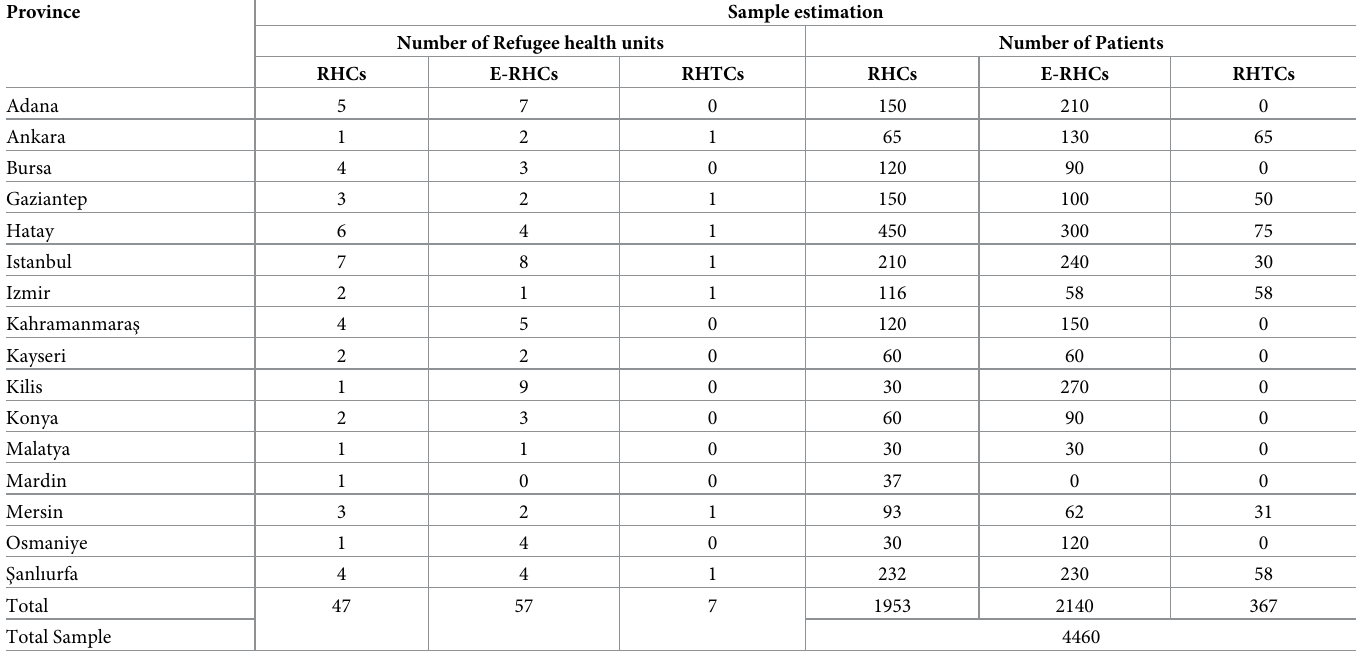
Table 1. Sample distribution by province and type of